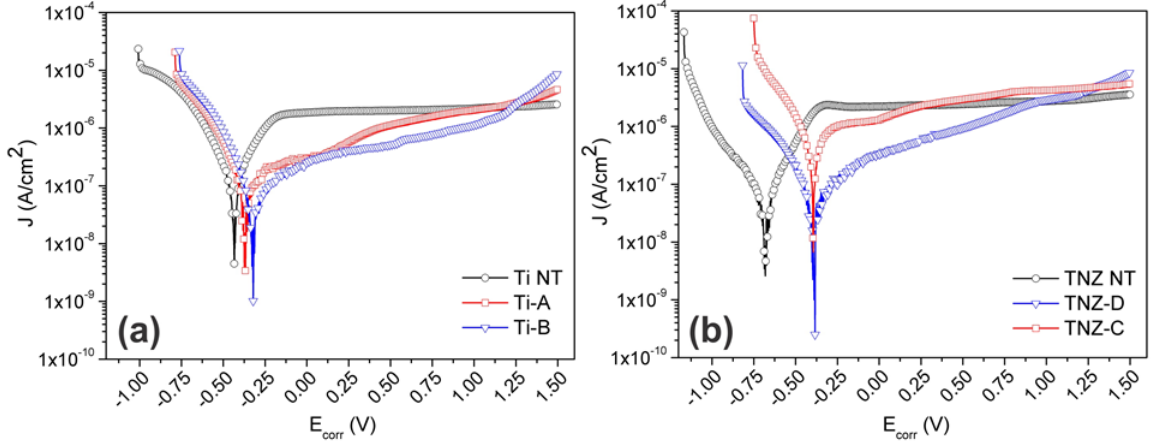
Figure 2. Potentiodynamic polarization curves in Hank’s solution at 37.5 °C of ( a) samples Ti NT, Ti-A, Ti-B; and ( b ) samples TNZ NT, TNZ-C,